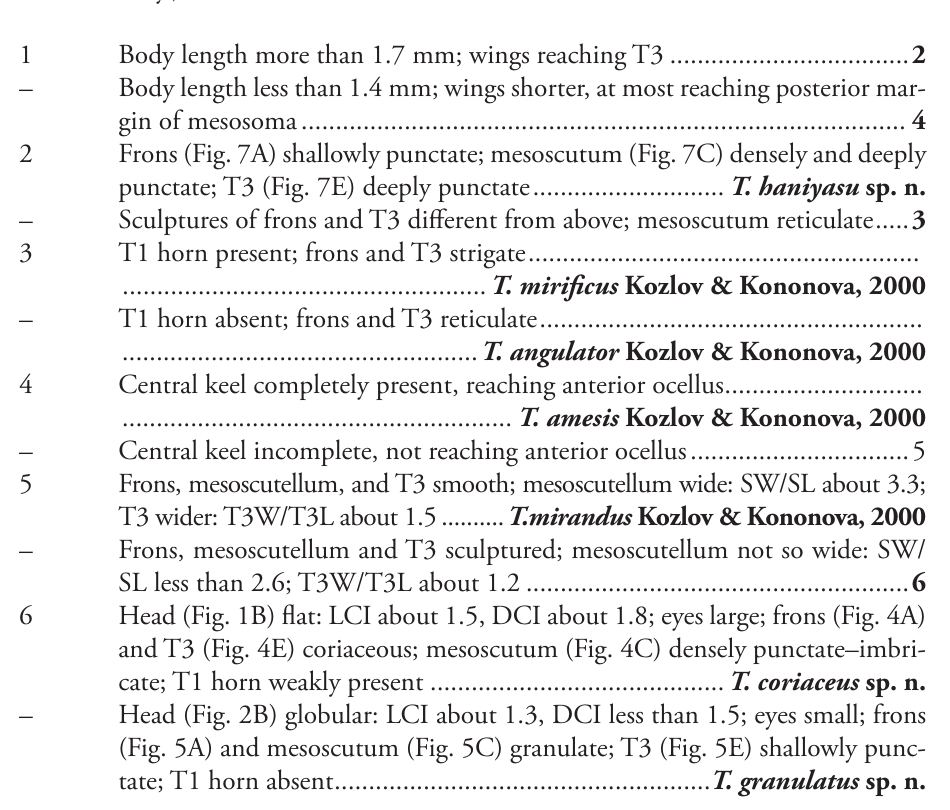
(Fig. 5A) and mesoscutum (Fig. 5C) granulate; T3 (Fig. 5E) shallowly